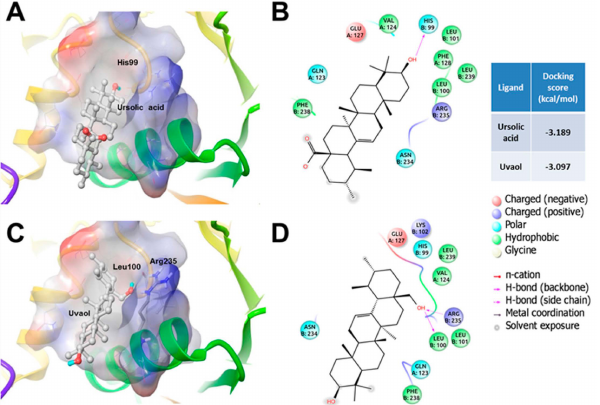
Figure 10. Binding mode of ursolic acid and uvaol into the CSE shared binding site: ( A ) short interactions (4.5 Å) of ursolic acid into the binding site; ( B ) 2D ligand interaction diagram of ursolic acid; ( C ) Short interactions (4.5 Å) of uvaol into the binding site; and ( D ) 2D ligand interaction diagram of